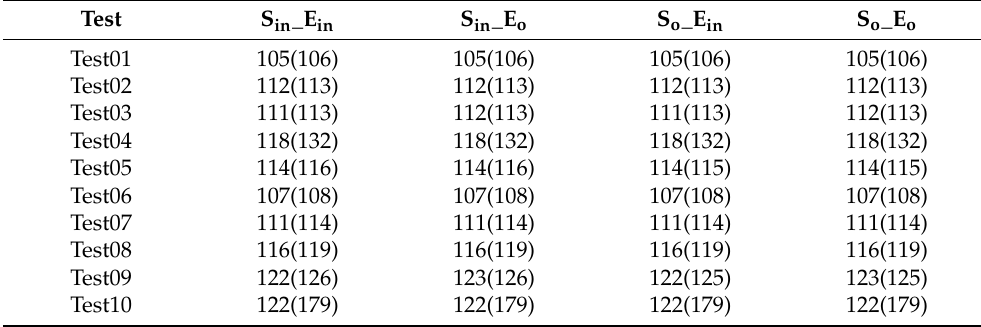
Table 2. Packet cross-matching results at